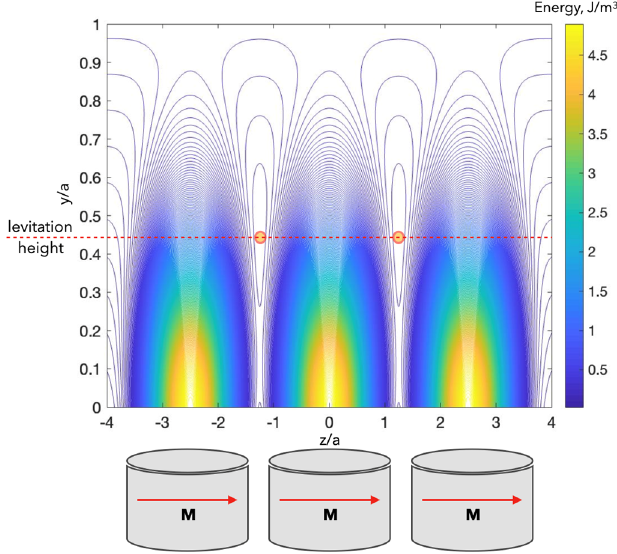
Figure 13. Equipotential energy density U ( x = 0, y , z ) for a periodic array of cylindrical magnets with in-plane magnetisation (Figure 12a,c). The total energy U includes magnetic and gravity energies (Equation (33)). g ∆ ρ = 0.2 × 10 4 N/m 3 ; ( χ p − χ ex ) = − 0.5 × 10 − 4 . The change in the z-coordinate is shown along three micromagnets (depicted in the figure), and the graphical image can be periodically continued along the z-axis.